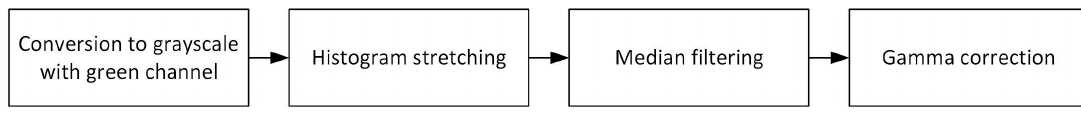
Figure 4. The block diagram of the image preprocessing algorithm.